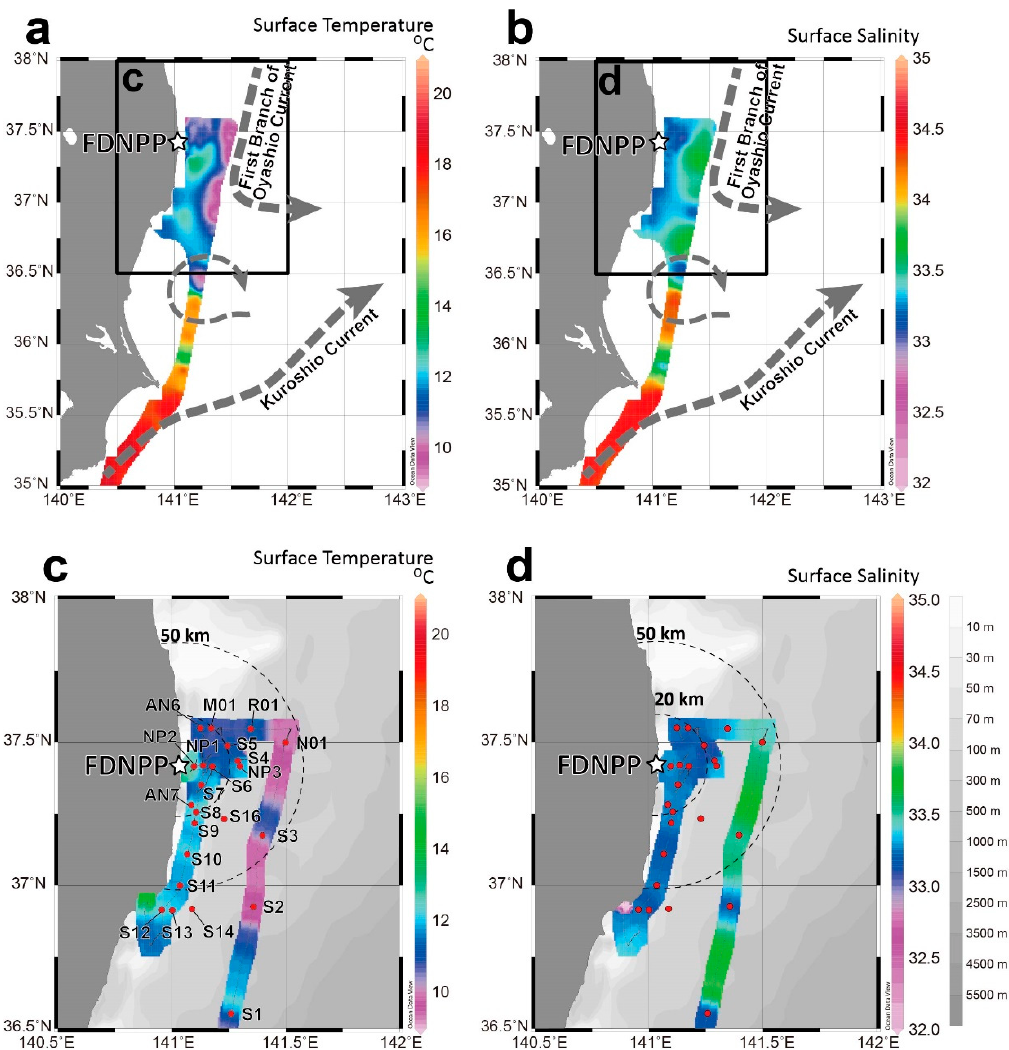
Figure 2. Maps showing sampling locations. ( a ) Surface temperature and ( b ) salinity had two boundary currents (dashed arrows), the warm northeastwardly Kuroshio current south of the Boso Peninsula and the cold southerly first branch of the Oyashio current off the Fukushima coast. ( c , d ) Sampling locations are marked by red circles and located near the coast of Fukushima Prefecture.